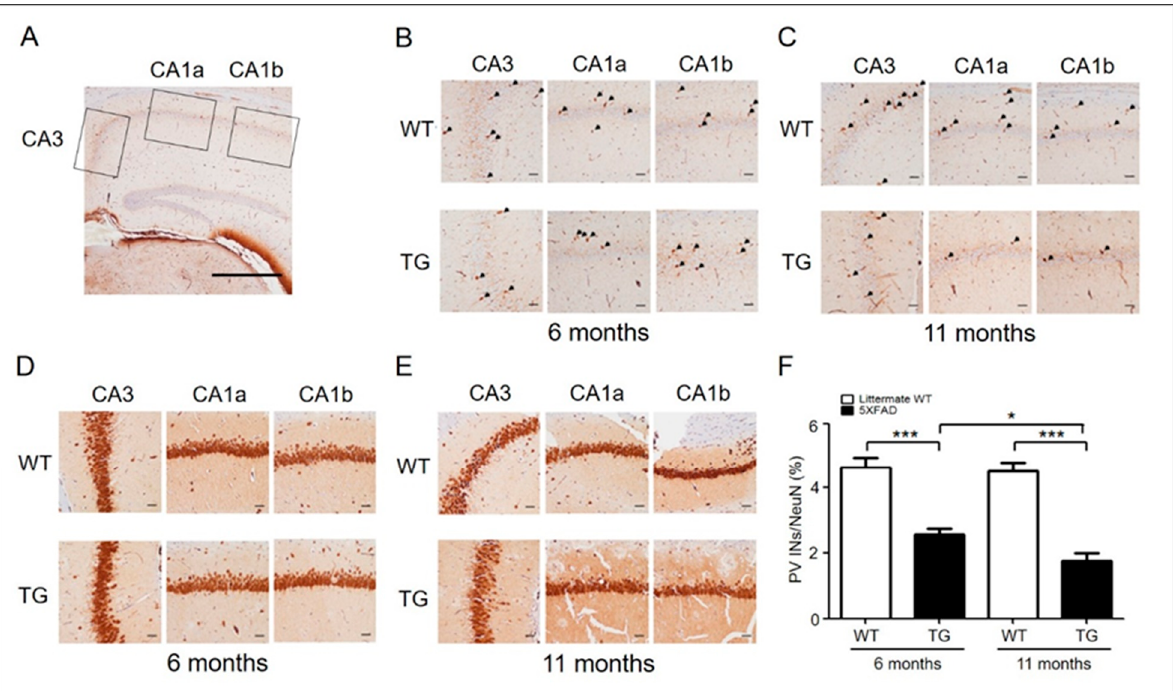
Figure 1. PV interneurons in AD mice (6-month-old adult and 11-month-old aged) and wild type. ( A ) Representative PV and NeuN immunohistochemical stains of the hippocampus CA3-CA1 region (original magnification, ×40) (scale bar = 500 μ m). ( B ) Representative PV immunohistochemical stains of the hippocampus of 6-month-old (adult) WT ( n = 6) and 5xFAD ( n = 6) mice. PV-positive interneurons are shown in the hippocampus at a closer distance from CA1a-b (original magnification, × 200, pointed by arrowheads) and CA3 (original magnification, ×200) (scale bar = 200 μ m). ( C ) Representative PV immunohistochemical stains of the hippocampus of 11-month-old (aged) WT ( n = 6) and 5xFAD ( n = 6) mice. ( D ) Representative NeuN immunohistochemical stains of the hippocampi of 6-month-old (adult) WT ( n = 6) and 5xFAD ( n = 6) mice. NeuN-positive cells are shown in the hippocampus at a closer distance from CA1a-b (original magnification, ×200, stained cells) and CA3 (original magnification, ×200) (scale bar = 200 μ m). ( E ) Representative NeuN immunohistochemical stains of the hippocampus of 11-month-old (aged) WT ( n = 6) and 5xFAD ( n = 6) mice. ( F ) The ratio of PV-positive cells to NeuN-positive cells in adult and aged 5xFAD mice (*, p < 0.05; ***, p < 0.0001 compared with the indicated group using unpaired t -test). AD, Alzheimer’s disease; PV, parvalbumin; INs, interneurons; NeuN, neuronal nuclei; CA, cornu ammonis; TG, transgenic; WT, wild-type.